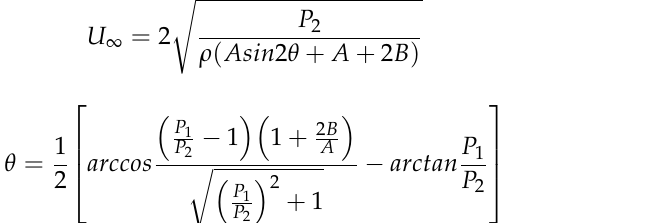
Figure 3. The measured pressure difference coefficients to ( a ) Reynolds numbers and ( b ) the azimuth angles.